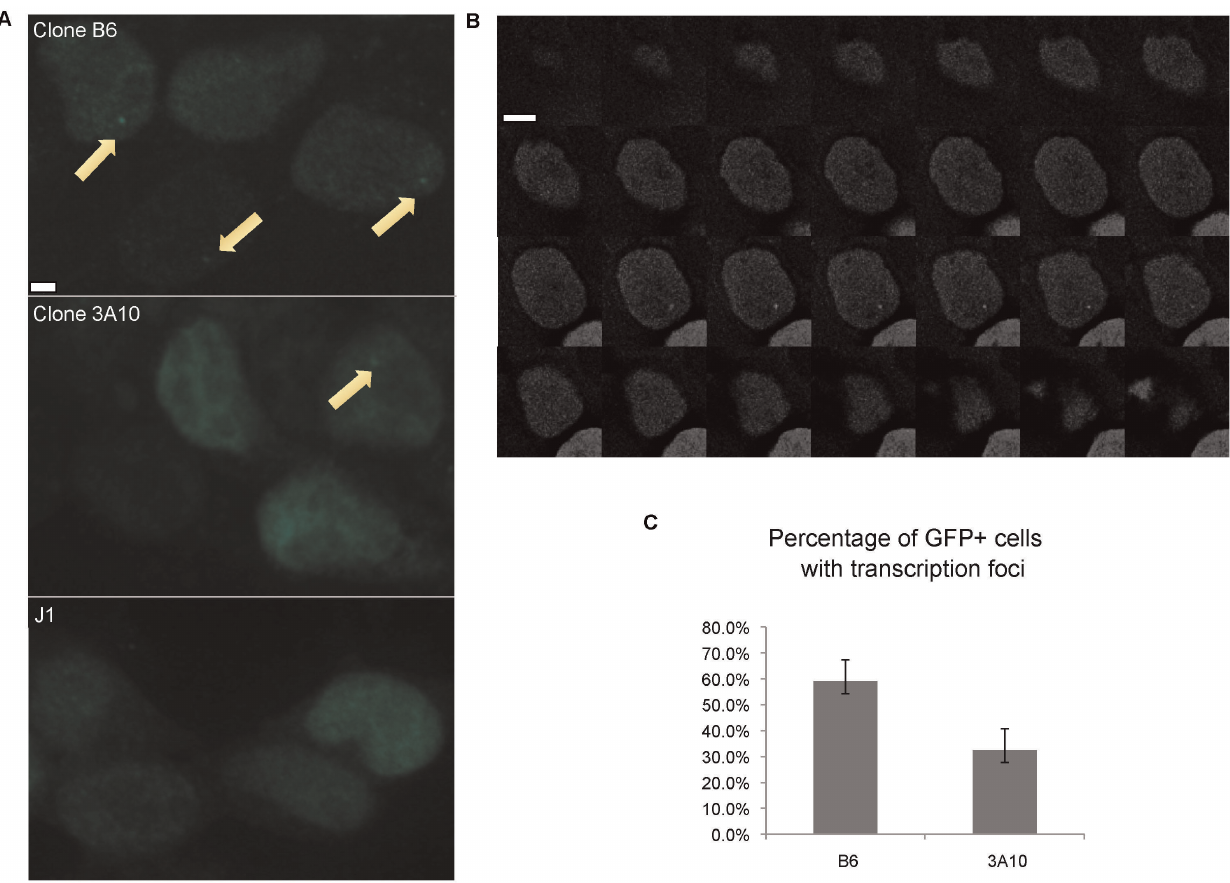
Figure 2. Visualization of transcription foci. A. Transcription foci were detected as focal dots (yellow arrows) in Clone B6 and 3A10 after transient transfection of MS2-EGFP. Uninfected J1 ES cells were used as a control. Scale bar=2.5 m M. B. Sample images from multiple z-stacks of a cell from Clone 3A10 displaying a focal dot over 6 consecutive focal planes. Z-stacks were 0.3 m M apart. Scale bar=5 m M. C. Quantification of the percentage of cells with transcription foci in EGFP-positive cells. (n=2; at least 47 cells were examined for each n).